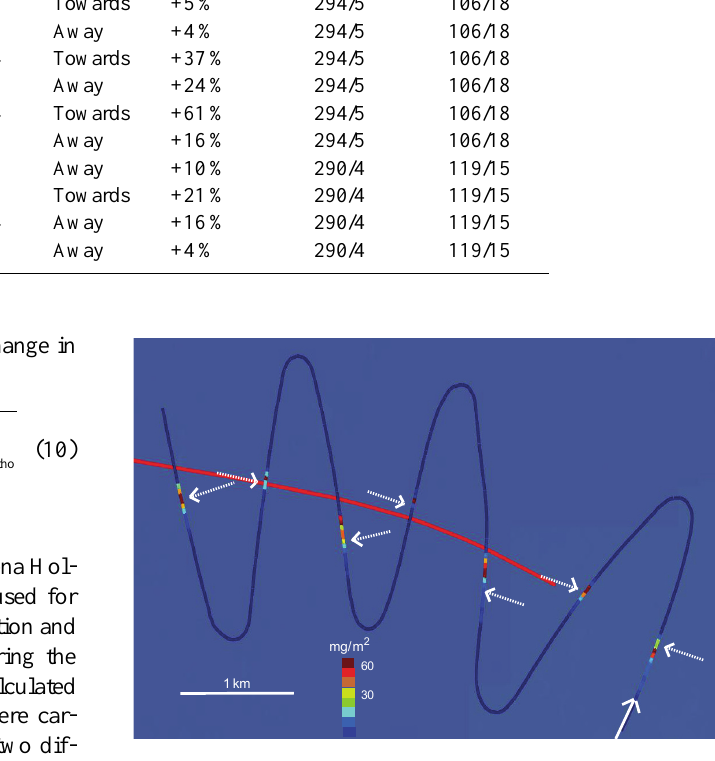
Fig. 12. An optical (DOAS) airborne measurement of the the Ro- Pax ferry Stena Hollandica at a distance of 15km from Rotterdam harbour. The ship, displayed with the red line, is travelling east- wards in NWW wind at around 03:00p.m.LT on 25 September. The flight path of the measuring helicopter is shown by the zigzag line with colour coded slant column values of SO 2 increasing from blue to red. The white dotted arrows indicate the direction of the in- coming light observed by the DOAS and the other arrow the flight